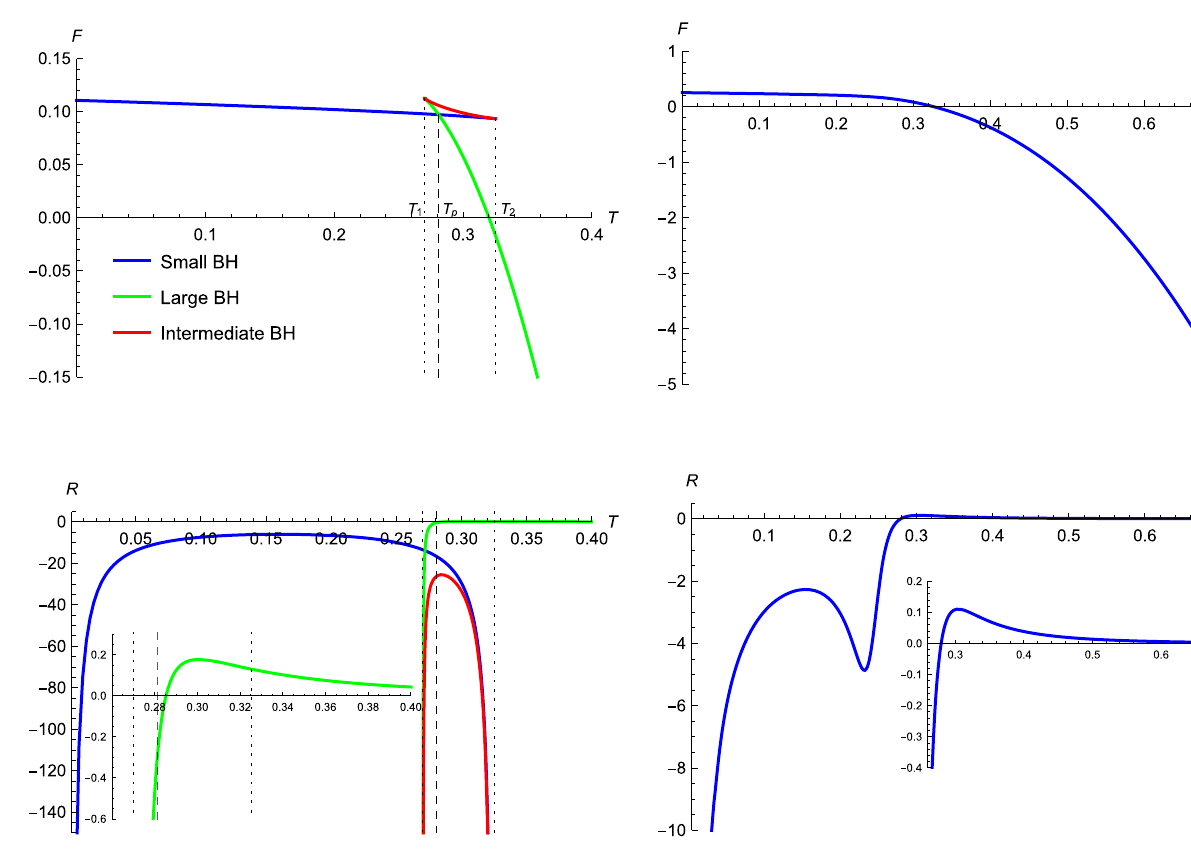
Fig. 2 Thefreeenergy F andtheRuppeinerinvariant R asfunctionsof the temperature T for a RN-AdS black hole with a fixed charge Q . Left Column: Q = 0 . 11 < Q c . There are three the black hole solutions when T 1 < T < T 2 . A LBH/SBH first-order phase transition occurs